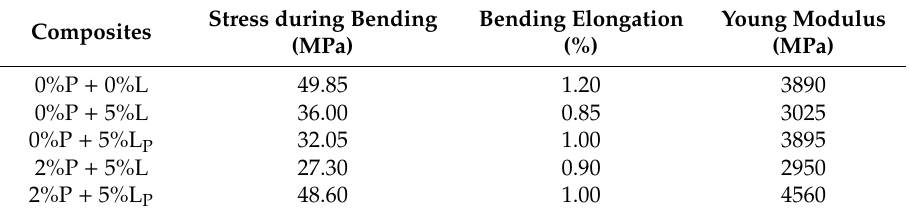
Table 3. Results of mechanical bending